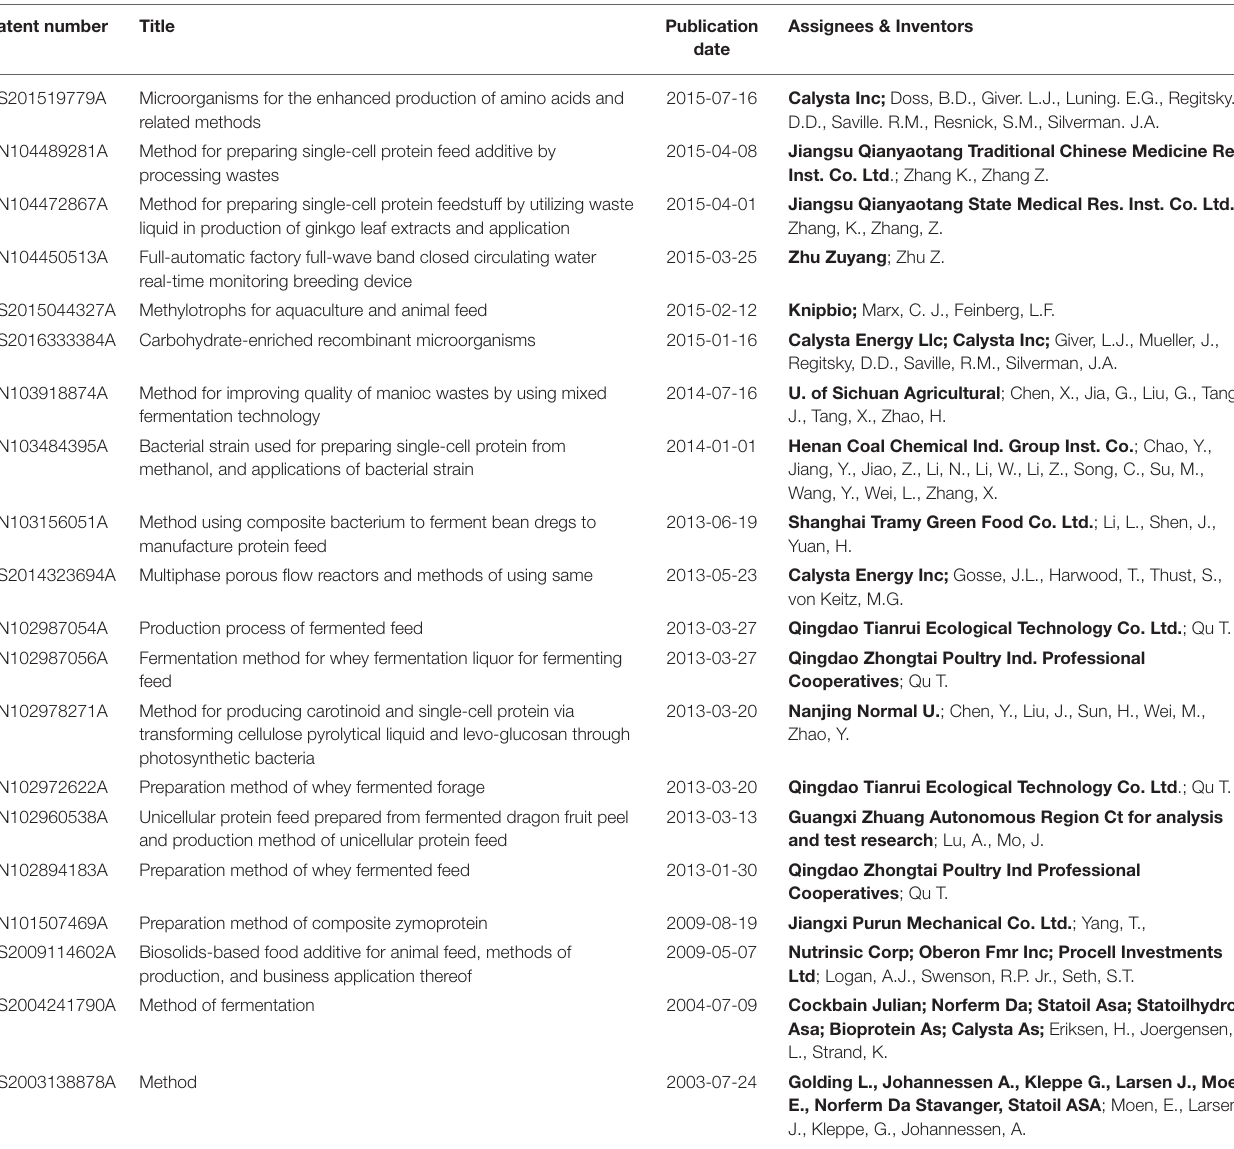
TABLE 7 | Patents related to the production of SCP from bacteria during